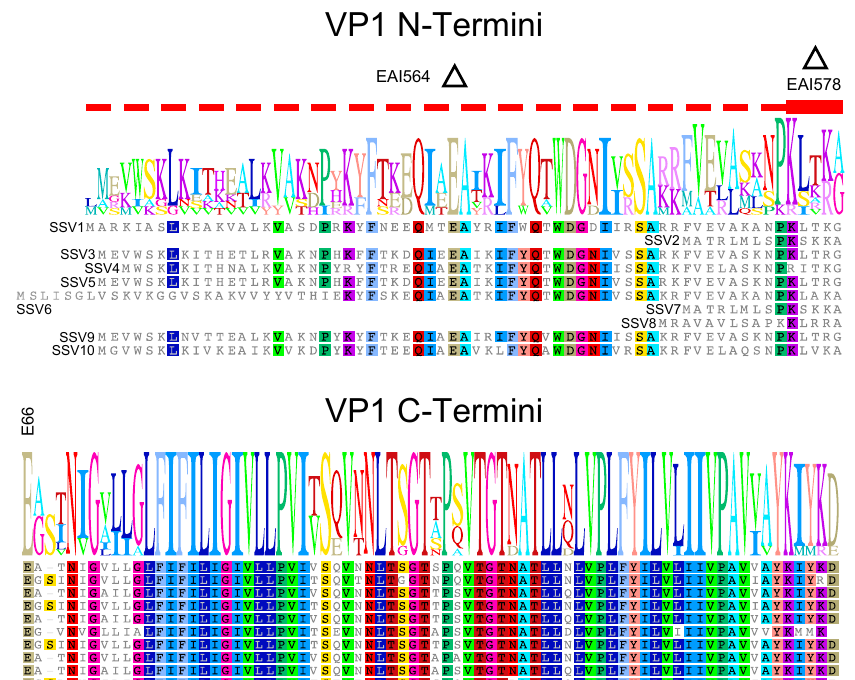
Figure 1. Amino Acid Sequence Alignment of Fusellovirus VP1 Proteins. VP1 protein sequences from Sulfolobus Spindle-shaped Virus 1 (SSV1) ( top ) to SSV10 ( bottom ) were aligned using Geneious V. 8.2 (Biomatters, Auckland, New Zealand) and edited by hand. Accession numbers are listed in reference 15. Identical amino acids are highlighted in color. Sequences present in 9/10 sequences or as an insert are also highlighted in color. A sequence logo is shown above the alignment. The alignment is split at the universally conserved glutamate (E) at position 66 in the SSV1 sequence where proteolysis occurs and labeled. The 6 amino acids that are deleted in construct EAI578 are indicated with a red bar and a delta symbol. The sequence that is deleted in construct EAI564 is indicated with a dotted red line and a delta symbol.